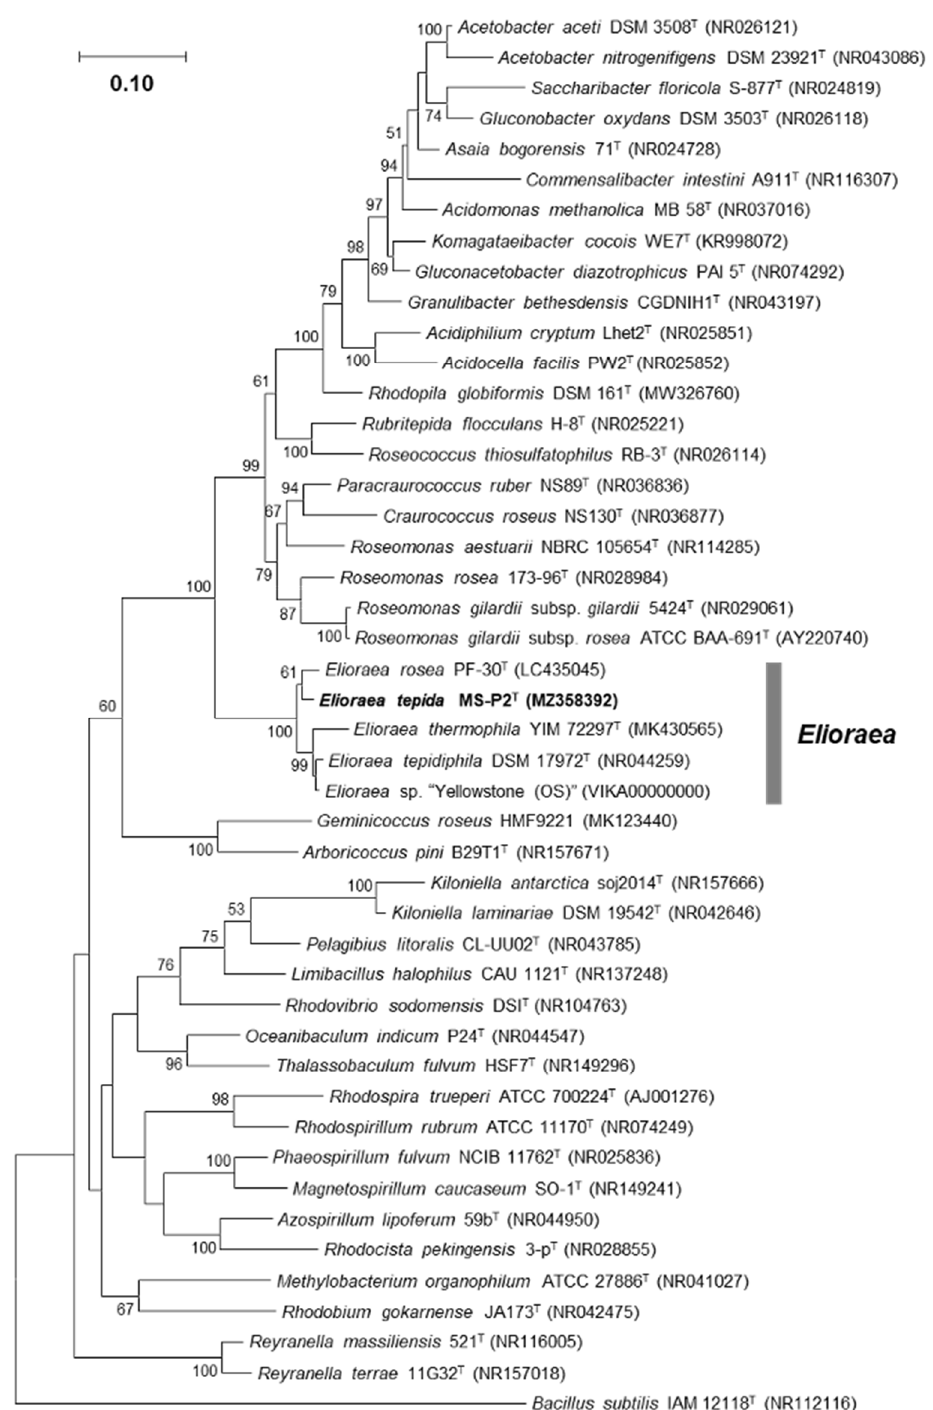
Figure 5. Phylogenetic tree based on 16S rRNA gene sequences constructed by the maximum-likelihood method based on the Kimura 2-parameter model [50] showing the phylogenetic position of strain MS-P2 T within the order Rhodospirillales . Robustness of the maximum-likelihood tree was tested by bootstrapping (100 resamplings, values > 50 are given at the nodes). Bacillus subtilis IAM 12118 T was used as an outgroup. The scale bar represents 0.10 substitution per site. Phylogenetic analyses were conducted in MEGA7 [49]. Trees made with neighbor-joining and maximum parsimony methods are very similar and can be seen in Supplementary Figure S4A,B.